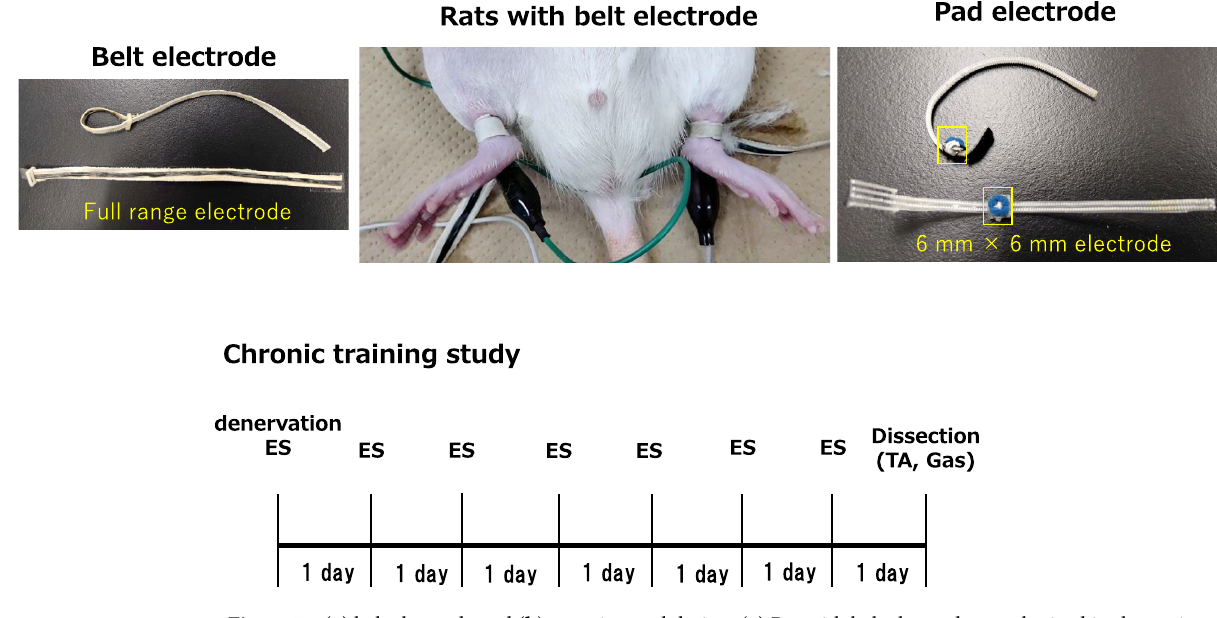
Figure 7. ( a ) belt electrode and ( b ) experimental design. ( a ) Rat with belt electrode anesthetized in the supine position. Hair on the right and left lower limbs was shaved, and belt electrodes were placed on the right and left ankles impregnated with saline. Pad electrodes were similarly placed on the left and right lower extremities behind the left and right ankles and impregnated with saline solution. ( b ) Study design for acute and chronic response. For acute response, the GAS and TA were removed immediately after 30 min of stimulation. For chronic response, the GAS and TA were removed 24 h after the last stimulation. All samples were obtained from the same experiment, and the gels/blots were processed in